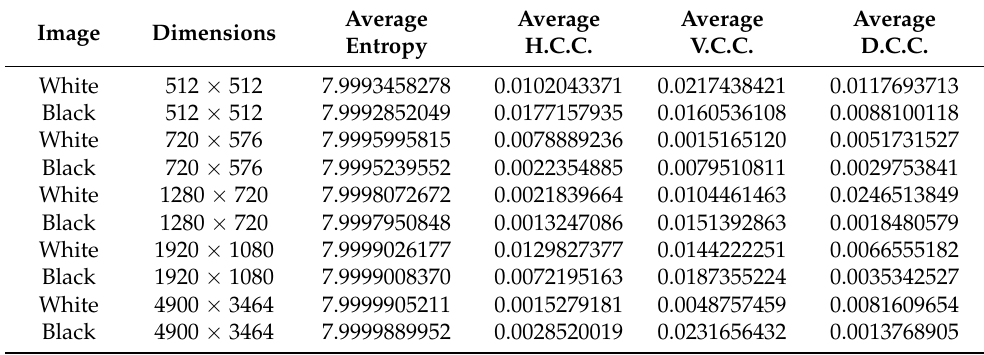
Table 10. Average entropy and correlation coefficient results of a black and white image.